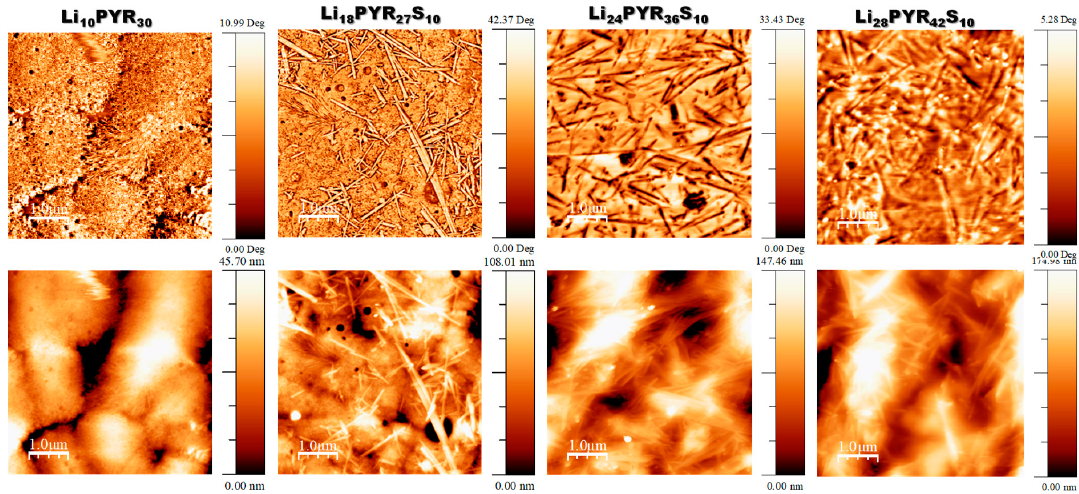
Figure 2. Phase and height AFM images of some of the electrolytes.